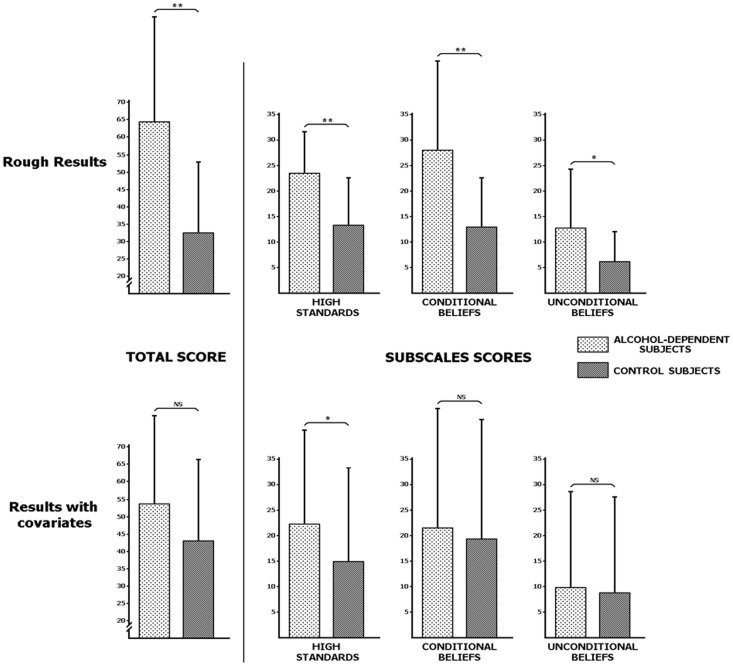
Self-Beliefs Social Anxiety Scale results for each group (alcohol-dependent and control subjects).Global scores are presented on the left and the scores for each subscale (high standards, conditional beliefs and unconditional beliefs) are presented on the right. The upper part depicts rough scores and the lower part depicts the scores corrected for depression (BDI score), anxiety (STAI A and B scores) and social anxiety (FNE and LSAS scores) using covariance analyses. Covariates appearing in the model are evaluated at the following values: 10.82 for BDI, 34.37 for STAI A, 40 for STAI B, 22.89 for LSAS and 14.47 for FNE. NS = Non-significant;*p<.01;**p<.001.